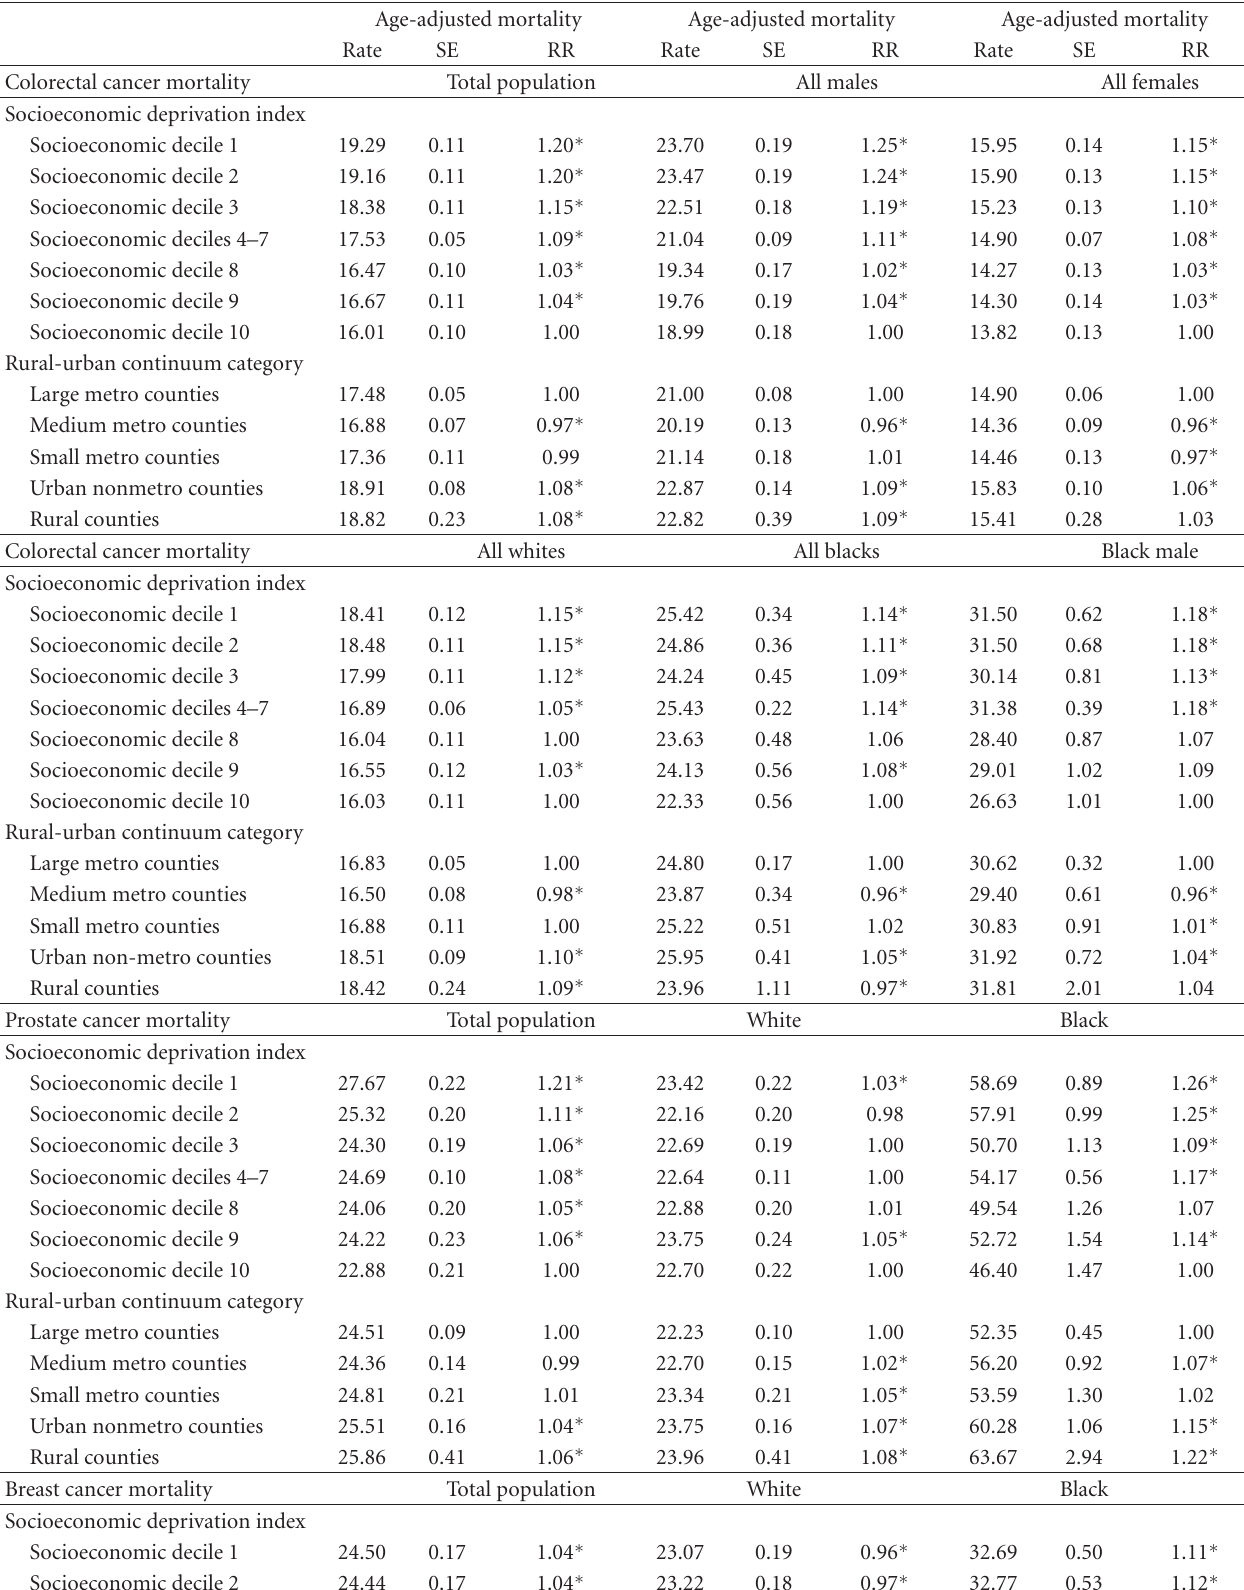
Table 5: Age-adjusted colorectal, prostate, breast, and cervical cancer mortality rates per 100,000 population and relative risk (RR)